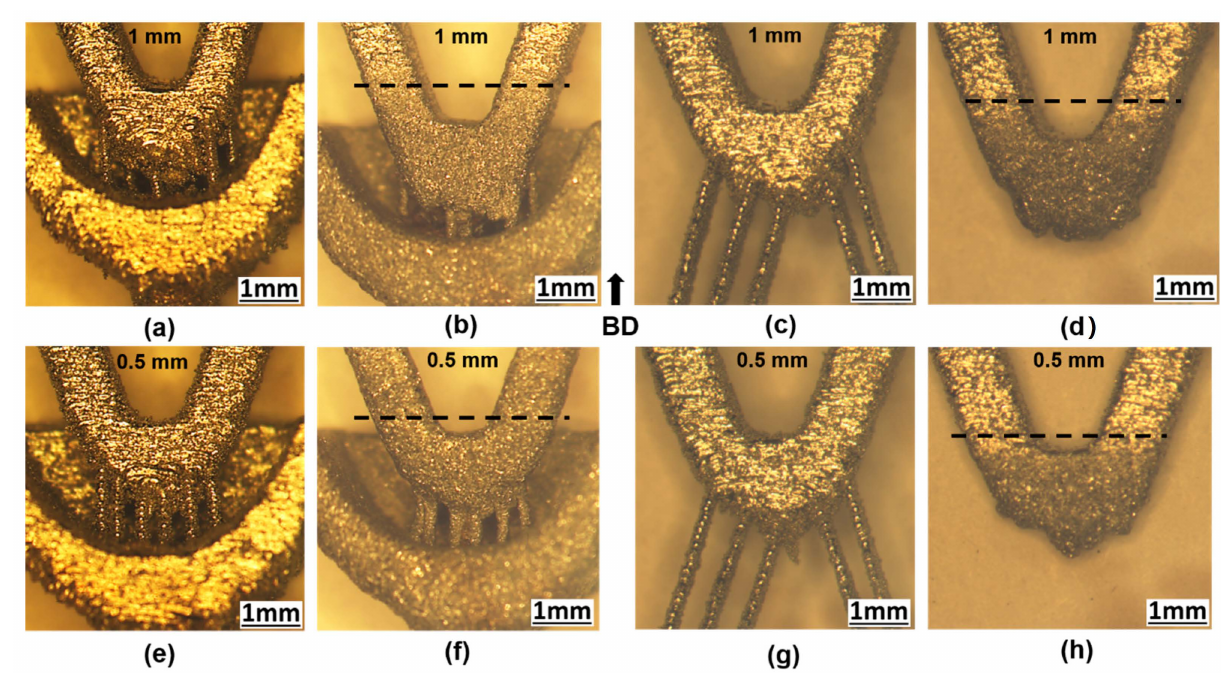
Figure 12. Light microscopy images depicting the influence of SB on the removal of support structures manufactured using strut thickness of ( a – d ) 1 mm and ( e – h ) 0.5 mm; for strut thickness of 1 mm, specimens fabricated using ( a , b ) cross support and ( c , d ) line support; specimens before ( a , c ) and ( b , d ) after SB; for strut thickness of 0.5 mm, specimens fabricated using ( e , f ) cross support and ( g , h ) line support, specimens before ( e , g ) and after ( d , h ) SB. Strut thicknesses are mentioned in each image together with the location of shield plate delineated using black dotted lines.